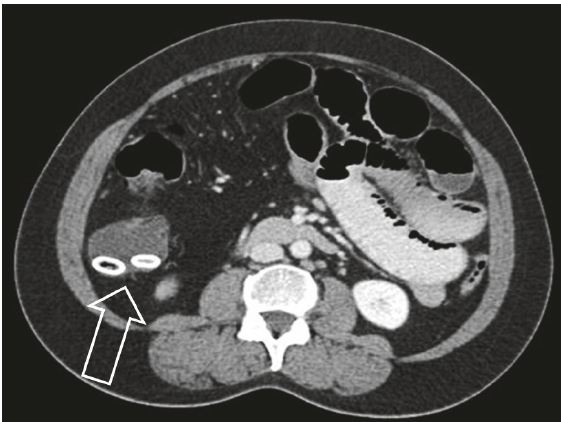
Figure 20: Computer tomographic image of two calcified fecaliths (arrow) in the cecum in a patient with ascending colon and ileal strictures due to Crohn’s